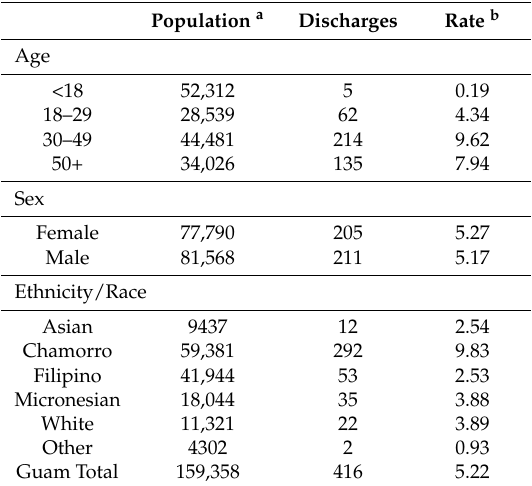
Table 1. Incidence of first-mentioned discharge for urolithiasis by age, sex and ethnicity/race, Guam Memorial Hospital,